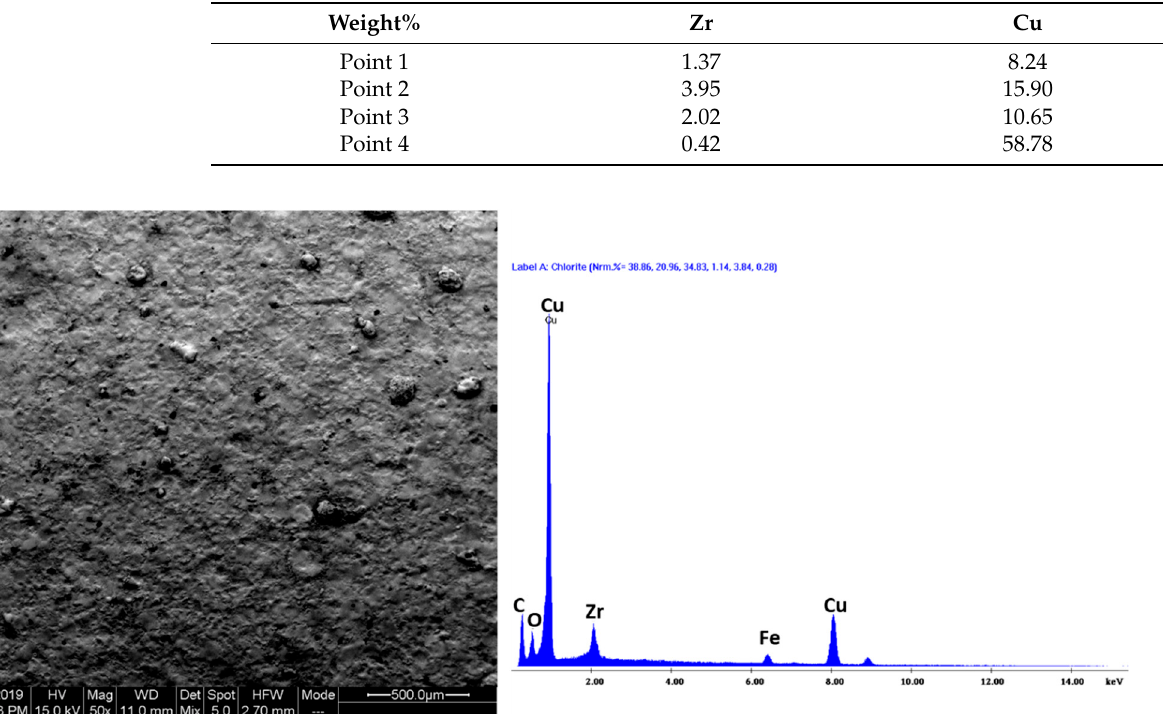
Figure 3. SEM micrograph of the machined surface for Ip = 5 A and Ton = 12.8 µ s. Table 4. Detailed EDS analysis of the machined surface for I p = 5A and T on = 12.8 µ s corresponding to Figure 3.